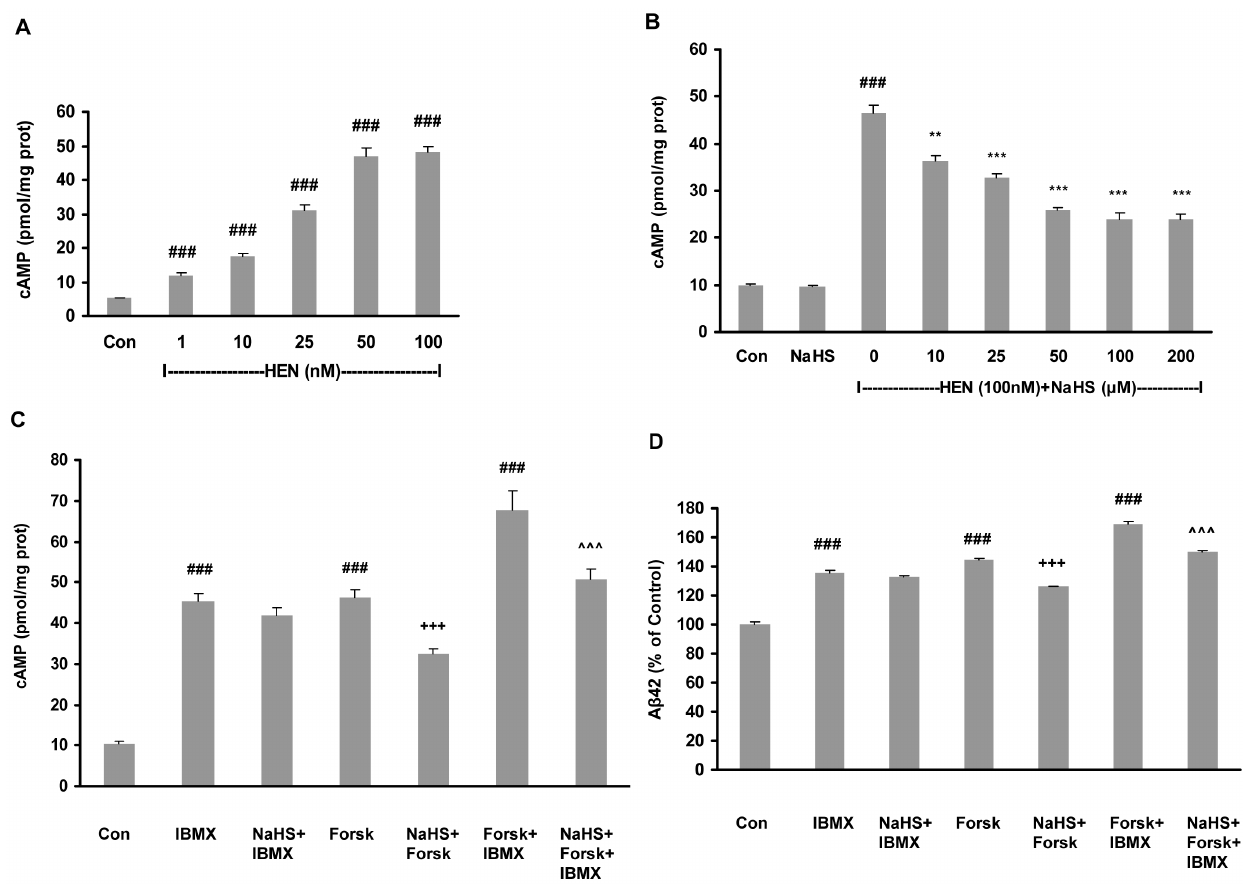
Figure 2. Effect of NaHS on A b 42 production involved cAMP signaling pathway. A : Dose-dependent effect of HENECA on cAMP production in SH-SY5Y cells expressing APPswe. B : Concentration-dependent effect of NaHS (10–200 m M, 12 hours) on HENECA (100 nM, 24 hours)-stimulated cAMP upregulation. C–D : Effects of NaHS (100 m M) on cAMP (C) and A b 42 production (D) in cells treated with forskolin (20 m M) and/or IBMX (100 m M). The intracellular cAMP and A b 42 levels in conditioned media were measured by sandwich ELISA kits. Control values were adjusted to 100% for A b 42 levels measurement. Data are given as means 6 S.E.M, n=6. ### p , 0.001 vs Con group, ** p , 0.01, *** p , 0.001 vs HEN group, +++ p , 0.001 vs forsk group, ˆˆˆ p , 0.001 vs forsk + IBMX group. Con, control; HEN, HENECA; Forsk,